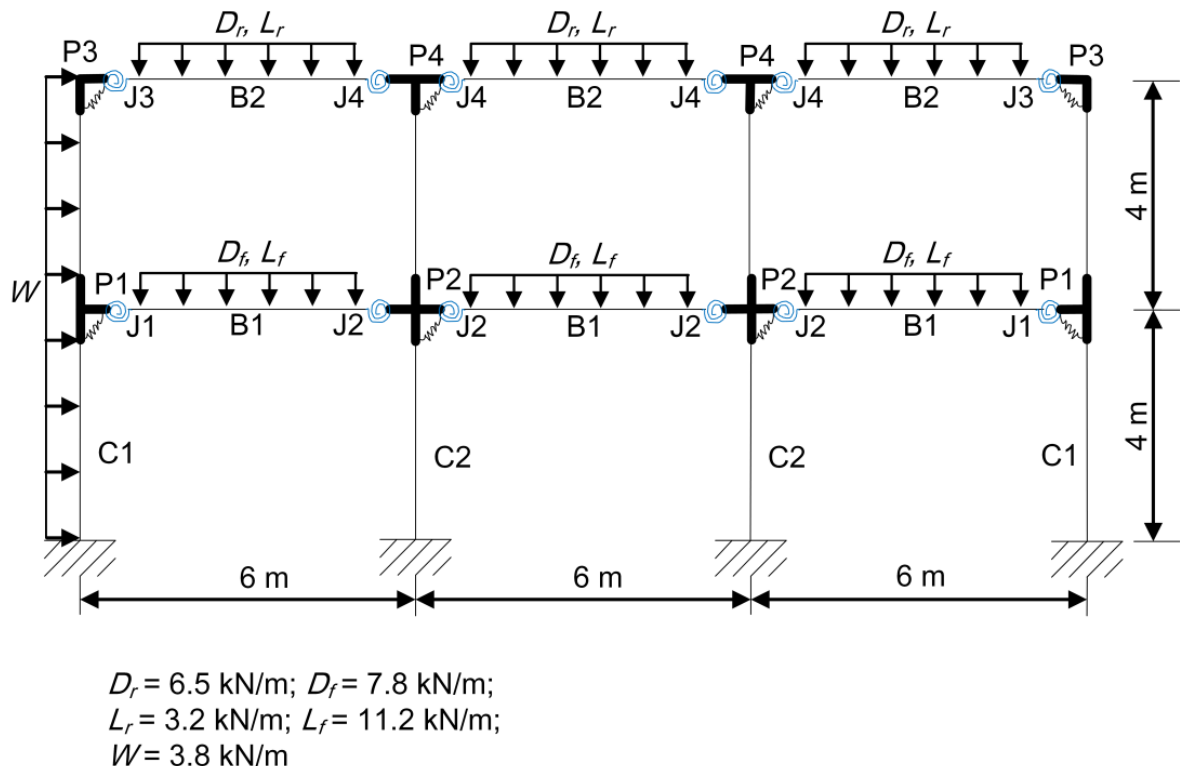
Figure 18. Three-bay, two-story frame.